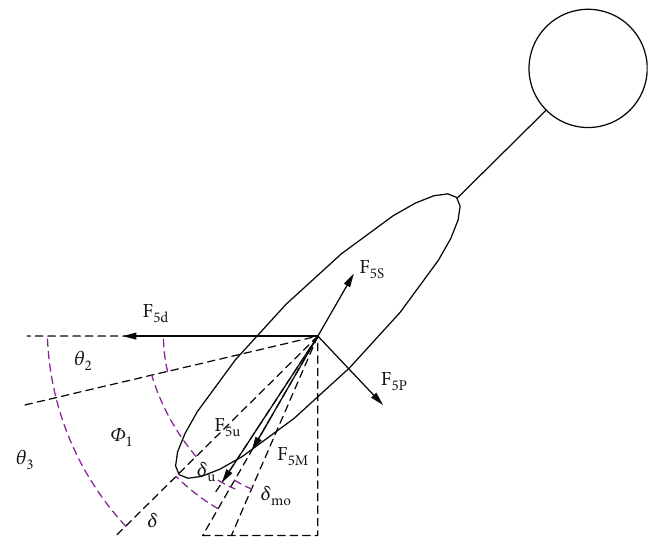
Figure 4: Force analysis of the third joint of the tail.